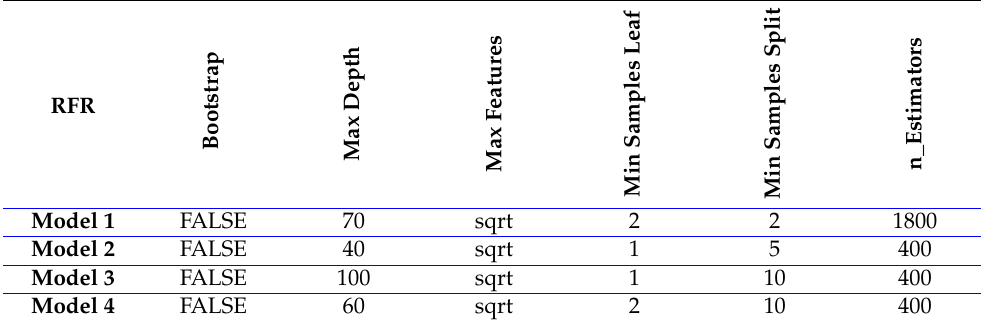
Table A5. Optimal hyperparameters for the RFR models (s-serie laser module).